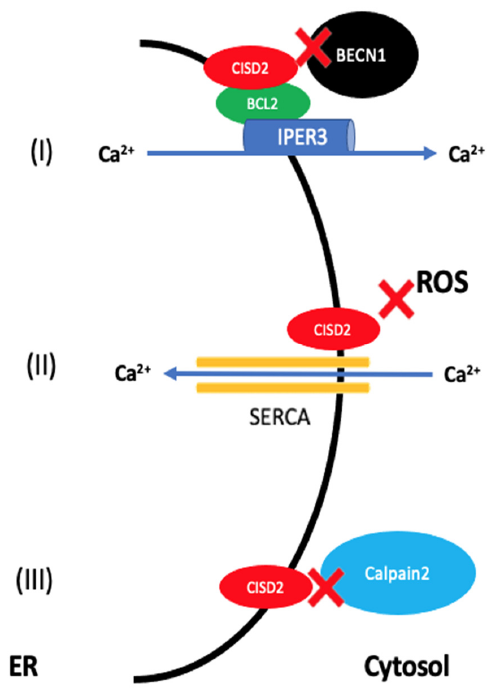
Figure 1. Main functions of CISD2 gene (modified from Shen ZQ et al.). ( I ) CISD2 forms a complex with BCL-2 that blocks BECN1-mediated autophagy. If CISD2 is deficient, BECN1-induced autophagy is uncontrolled. In addition, the CISD2-BCL-2 complex regulates mitochondrial Ca 2+ homeostasis via IP3R. Mutations in CISD2 may impair the function of IP3R and thus calcium homeostasis. ( II ) CISD2 regulates reduction-oxidation mechanisms by preventing oxidation of SERCA proteins, which are essential for cytosolic Ca 2+ transport in the ER. CISD2 deficiency reduces SERCA activity resulting in increased cytosolic Ca 2+ , increased ER stress and ROS production. ( III ) CISD2 inhibits apoptosis mediated by Calpain2 and caspase 3. In the absence of CISD2, activation of Calpain2 leads to increased apoptotic processes.